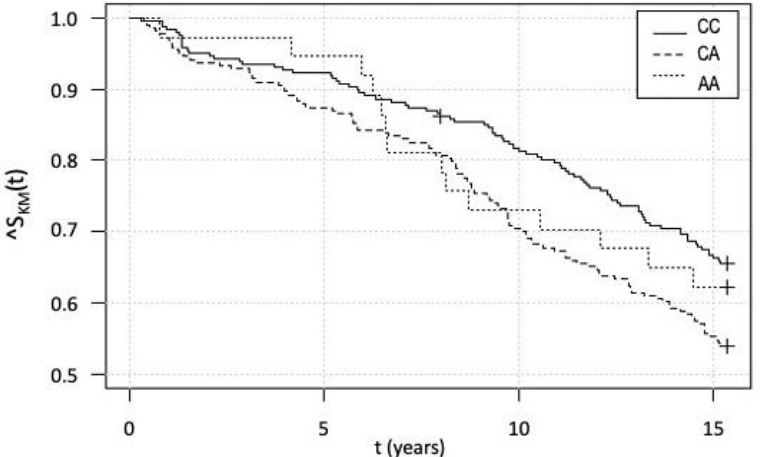
Figure 2. Kaplan–Meier survival analysis for individual genotypes within the 15-year-long follow up. A more detailed explanation can be found in the text.